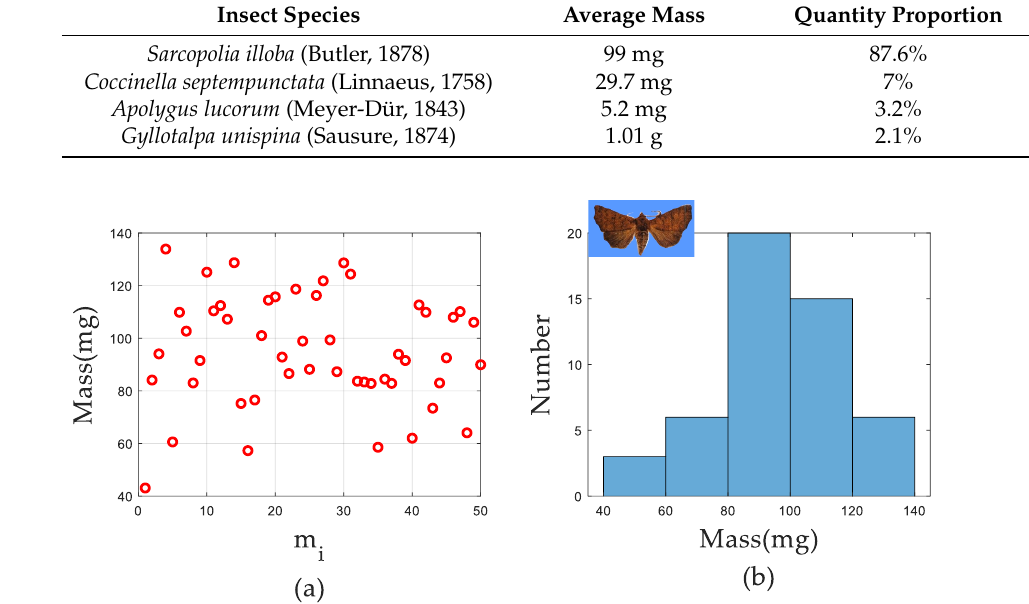
Figure 12. Statistical results of the mass measurement of the captured insects. ( a ) Mass measurement results. ( b ) Statistical results for the mass.